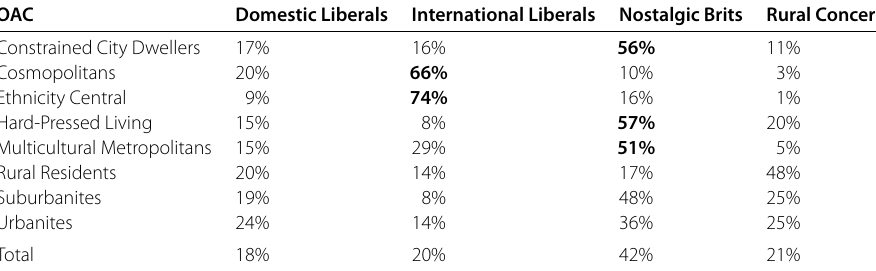
Table 4 Correspondence between OAC and class